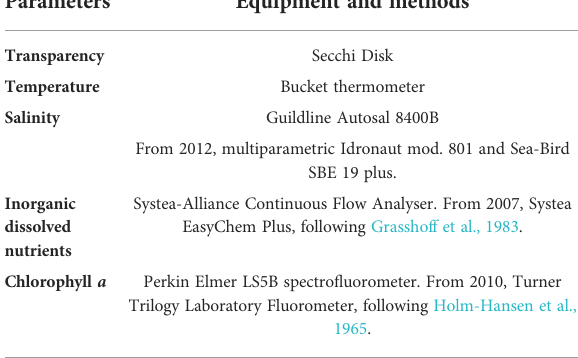
TABLE 1 Investigated parameters, equipment and